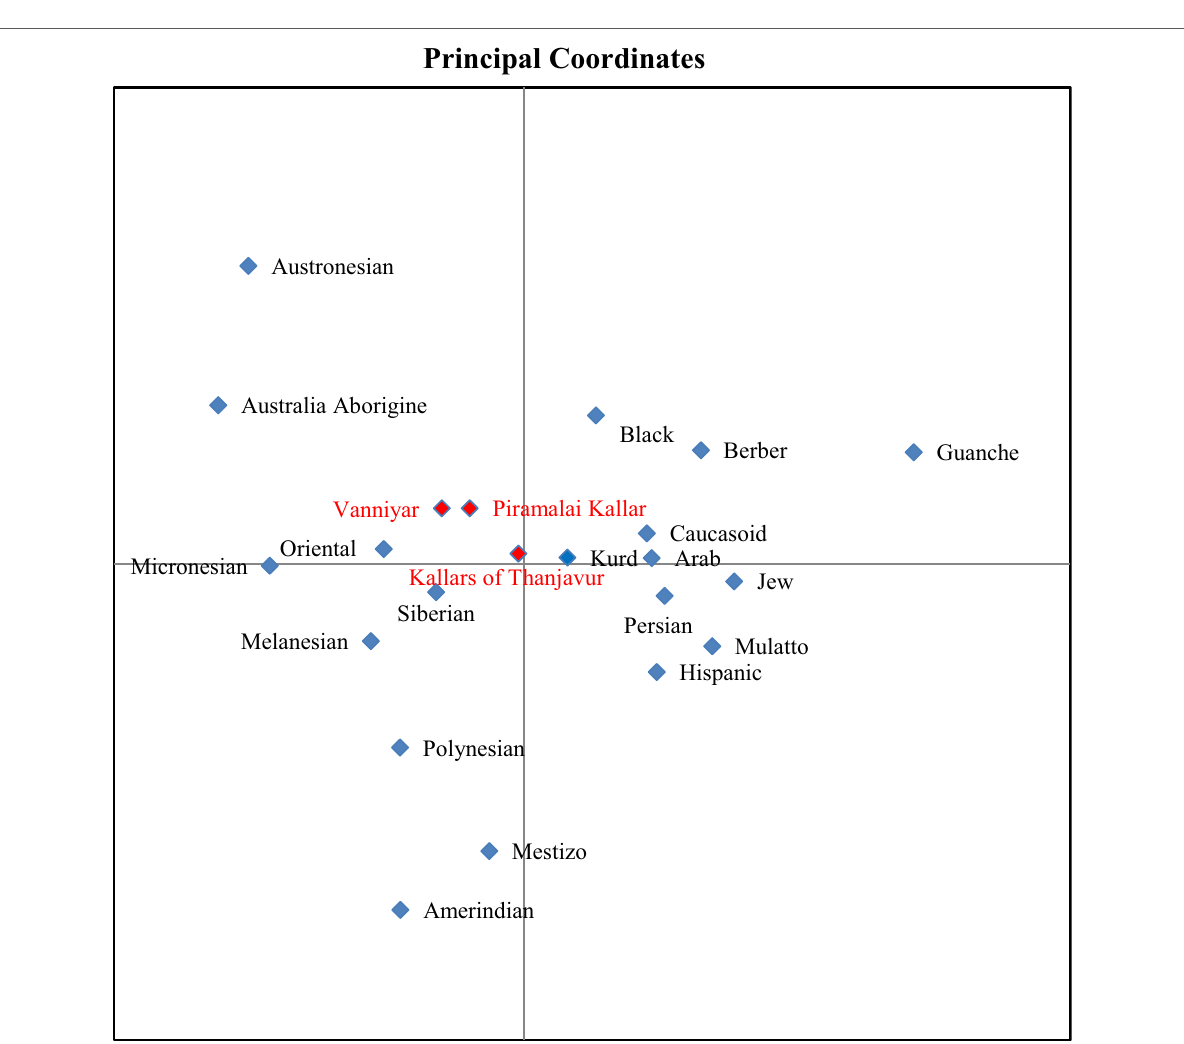
Fig. 2 Principal component analysis (PCA) showing of the relationship between the South Indian and other selected global populations based on frequencies of HLA-DRB1 alleles. Frequency data for other populations were from